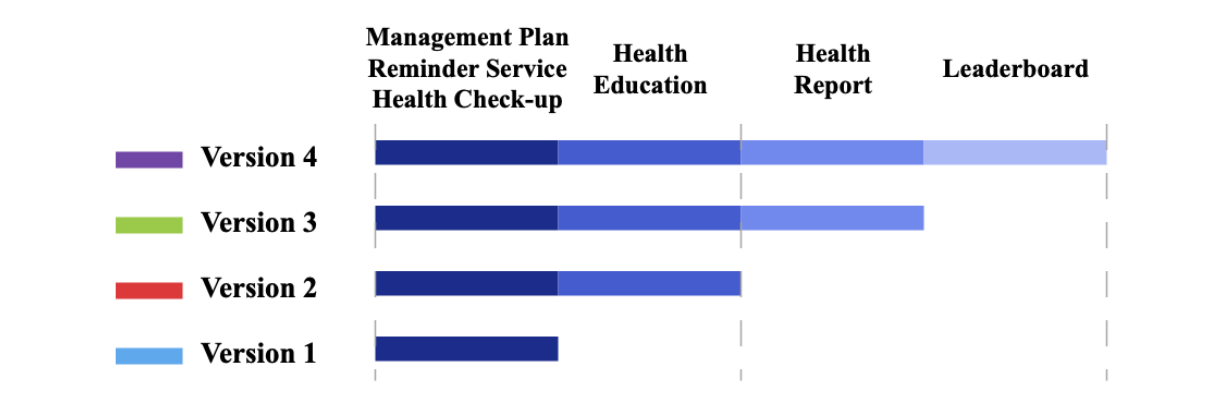
Figure 11. Functional modules contained in each